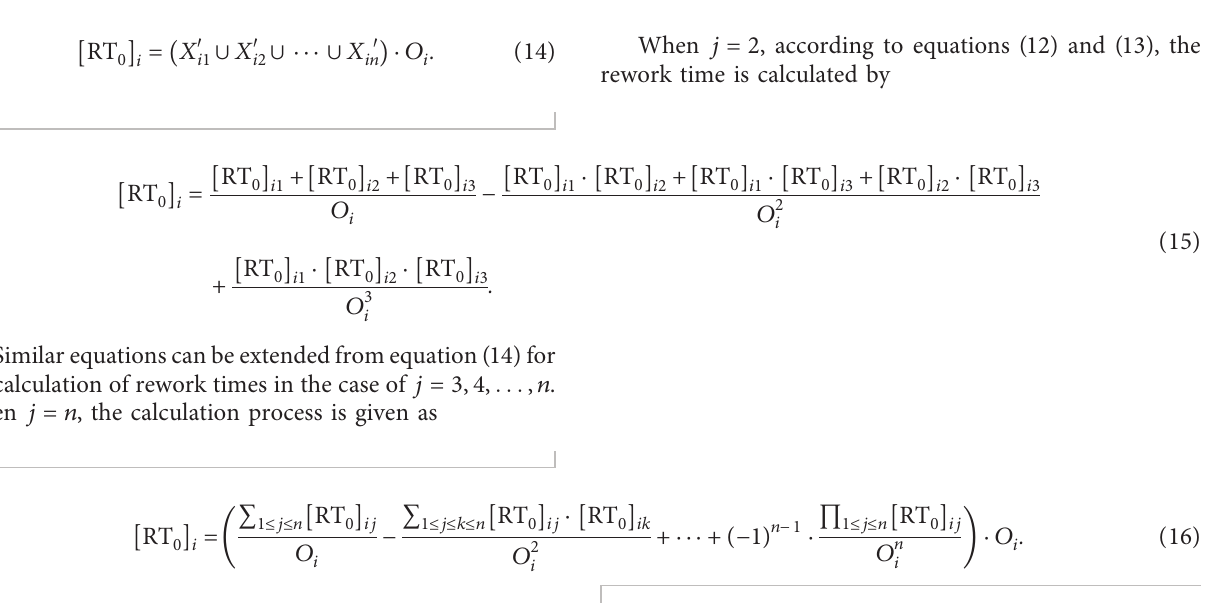
Figure 5: Effects of overlaps with multipredecessors on calculation of rework